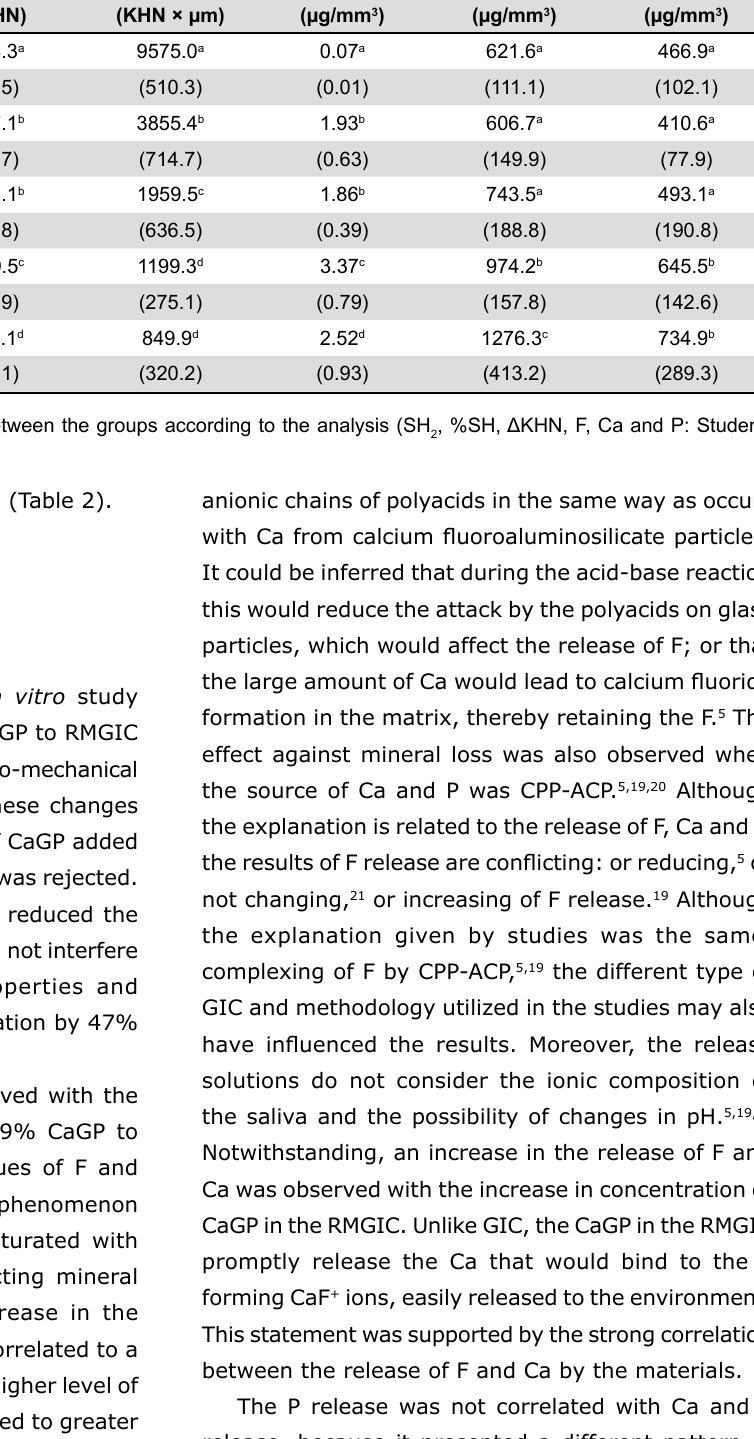
), percentage surface hardness loss (%SH), integrated loss of subsurface 2